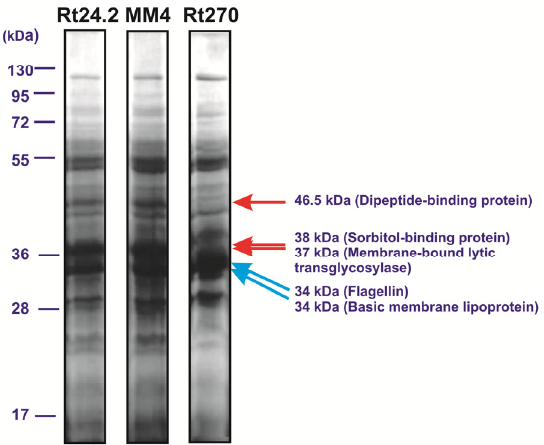
Figure 5. Extracellular protein profiles of the R. leguminosarum bv. trifolii wild-type strain 24.2 and two EPS-deficient Rt270 and MM4 mutants. The migration positions of molecular mass markers are shown. Individual slot contains 15 µg of the extracellular protein fraction. Protein bands missing or of decreased amounts in the pssA mutant profile are marked by red arrows, whereas proteins of higher amounts in relation to the wild-type profile are marked by blue